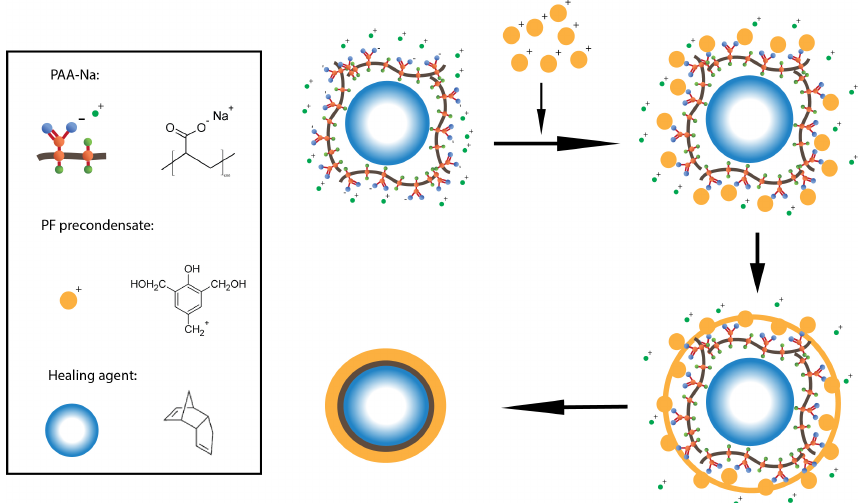
Figure 1. Schematic illustration of the chemical reaction route of PF shell/DCPD core microcapsules via in situ